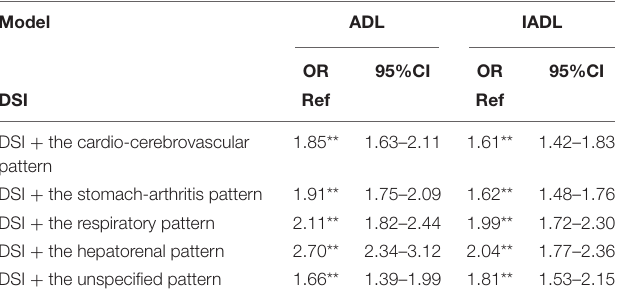
TABLE 3 | Longitudinal association between functional impairment and DSI and multimorbidity patterns ( N = 5,153).